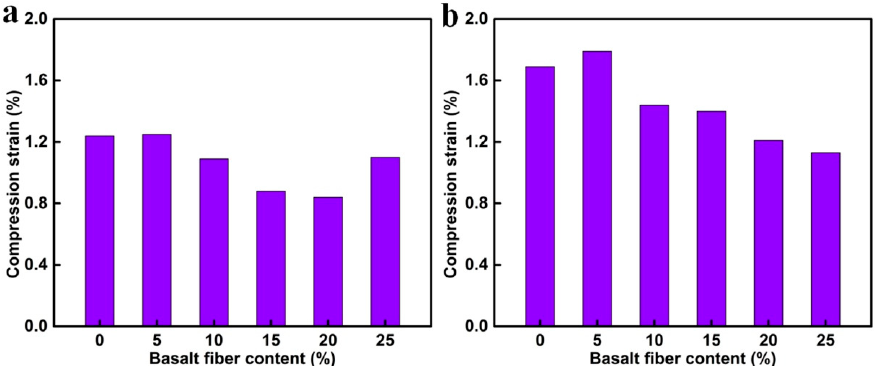
Figure 3. Compression strain of the friction composites: ( a ) at room temperature and ( b ) at the temperature of 400 °C .